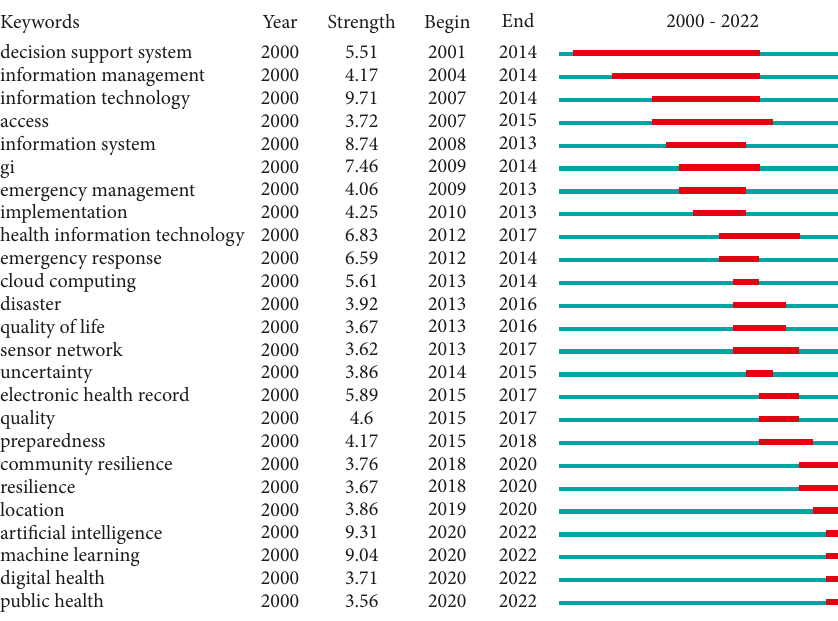
Figure 14: Top 25 keywords with the strongest citation bursts of international DEM